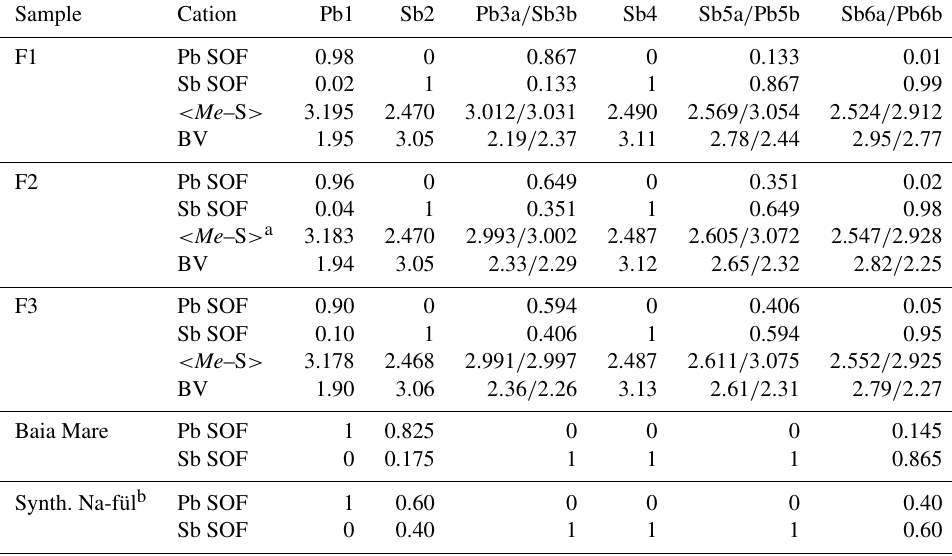
Table 3. Pb-versus-Sb distribution (SOF), average bond distances < Me –S > , and cation bond valences (BVs) in the studied samples of fülöppite. For the sake of comparison, cation distribution in fülöppite from Baia Mare (Edenharter and Nowacki, 1974) and synthetic Na derivative of fülöppite (Swinnea et al., 1985) are shown.